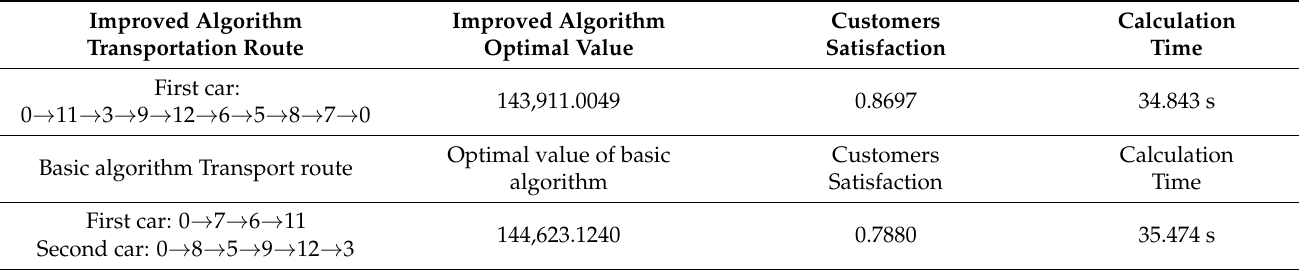
Table 6. Optimization